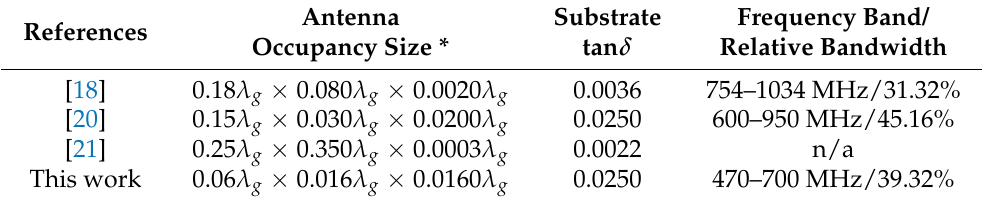
Table 4. Performance comparison with related